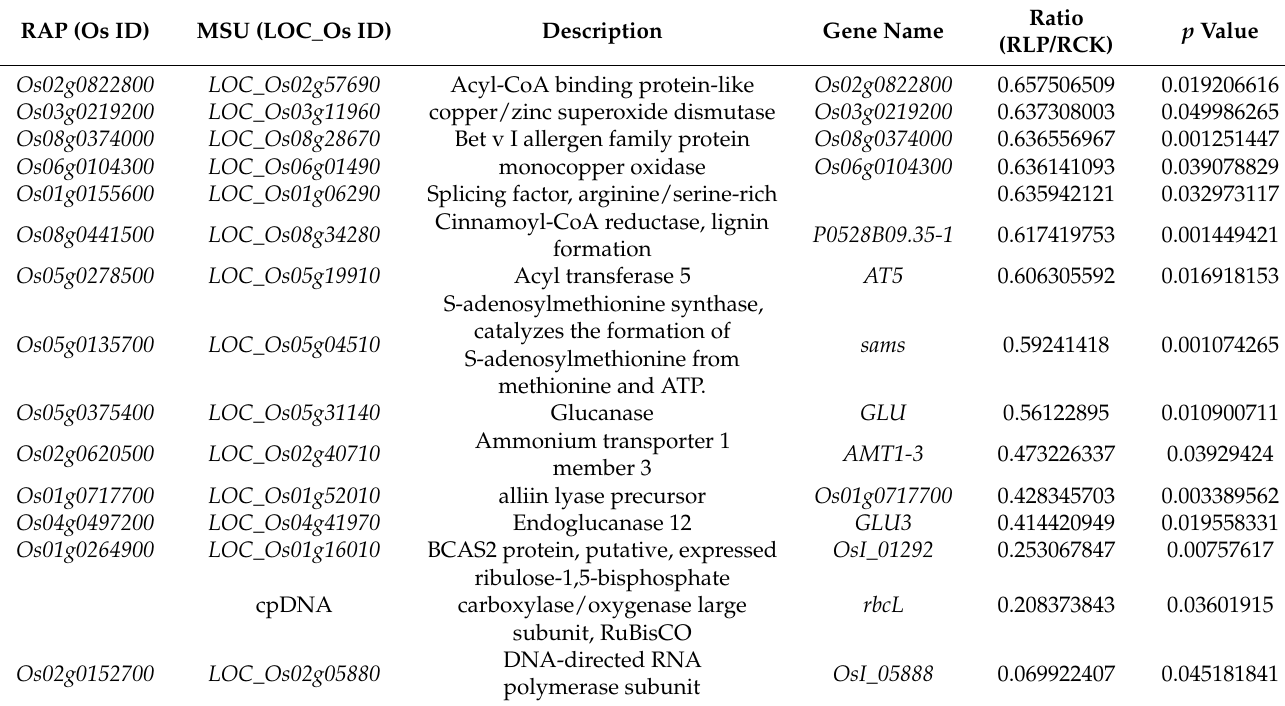
Table 2. Downregulated proteins identified from label-free quantitative